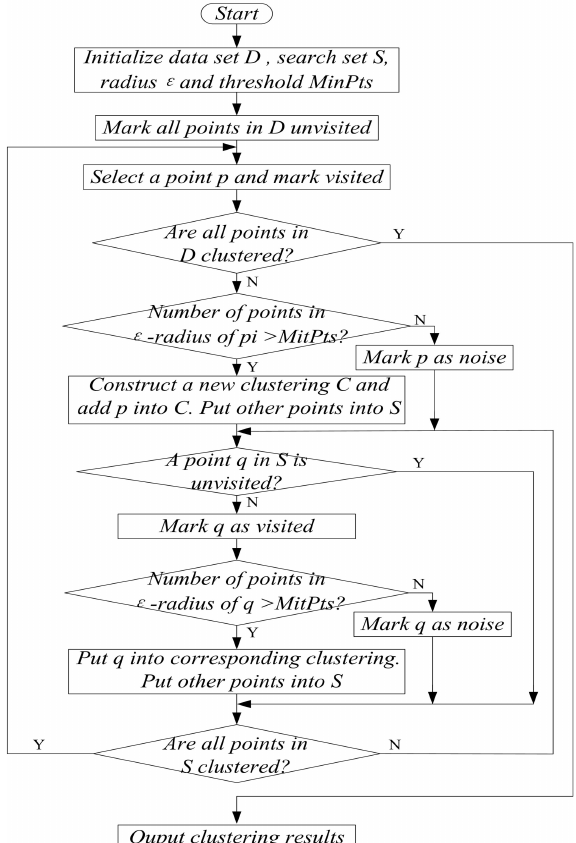
Figure 1. The working flowchart of density-based spatial clustering of applications with noise